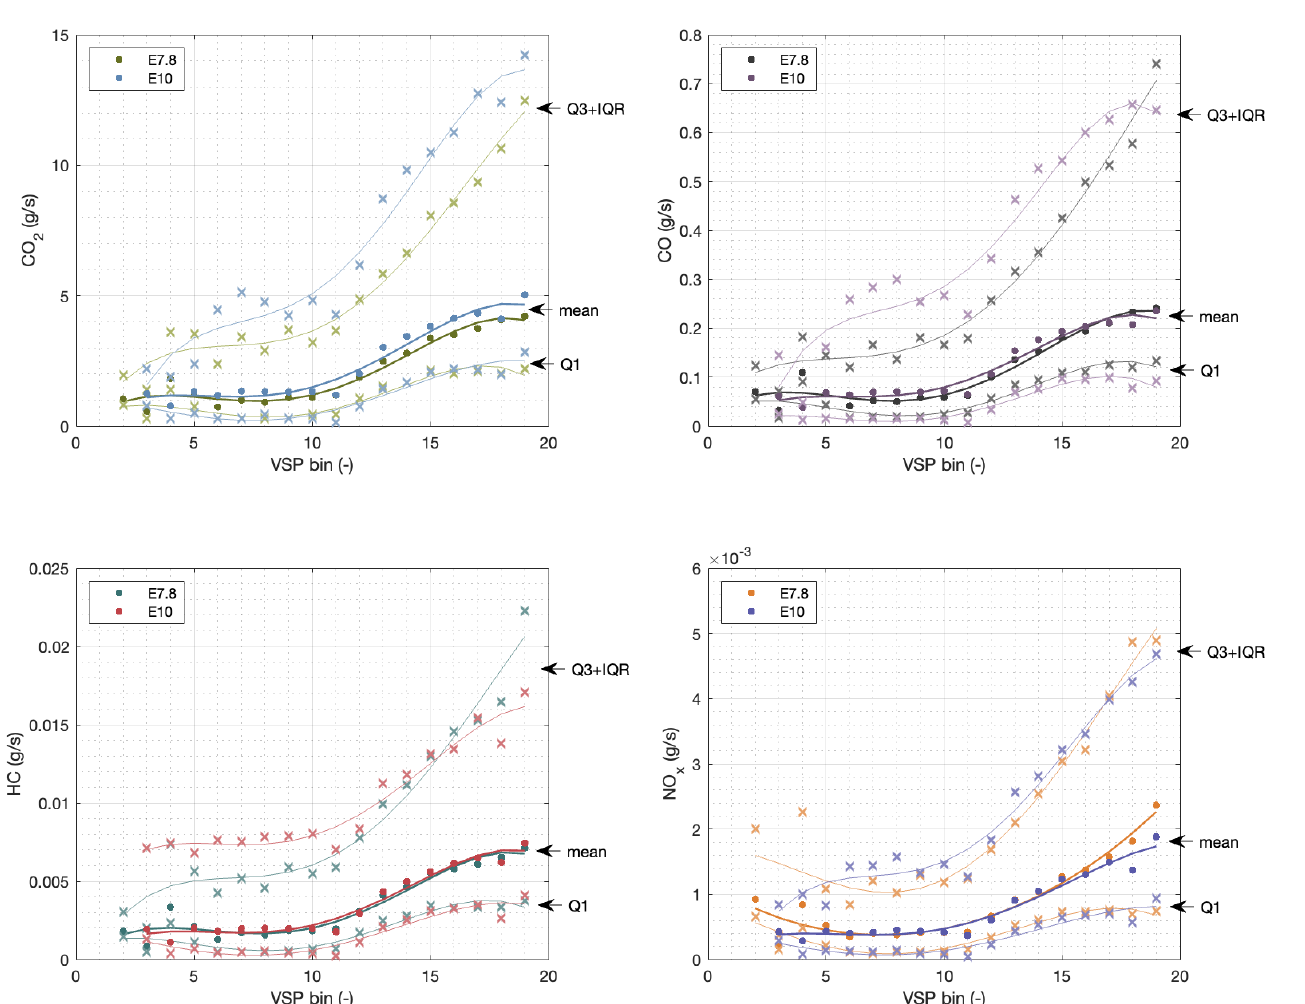
Figure 14. Comparison of mass flow distribution main values between fuel blends. These results indicate that the main difference between fuel blends was in the sparsity of the samples, which can be better viewed in the plot for the standard deviation per bin, as shown in Figure